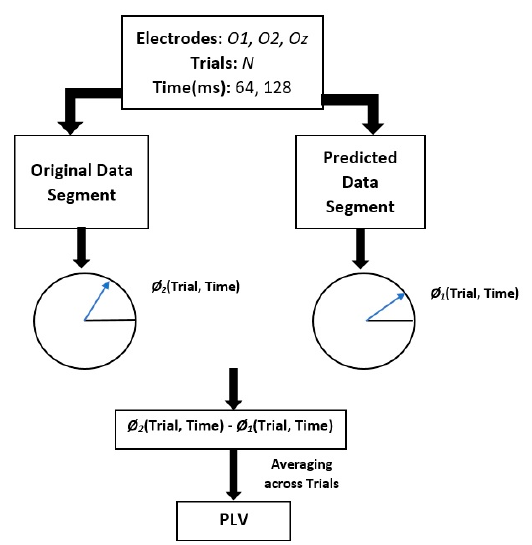
Figure 3. Diagram of calculation method of phase-locking value (PLV) [42] between origanl and predicted data segments. Intertrial variability of phase differences between the original and predicted data segments from the same electrodes was calculated. PLV was calculated for three different electrodes (O1, O2, and Oz) and at three different time points (0, 128, 256 ms), respectively.